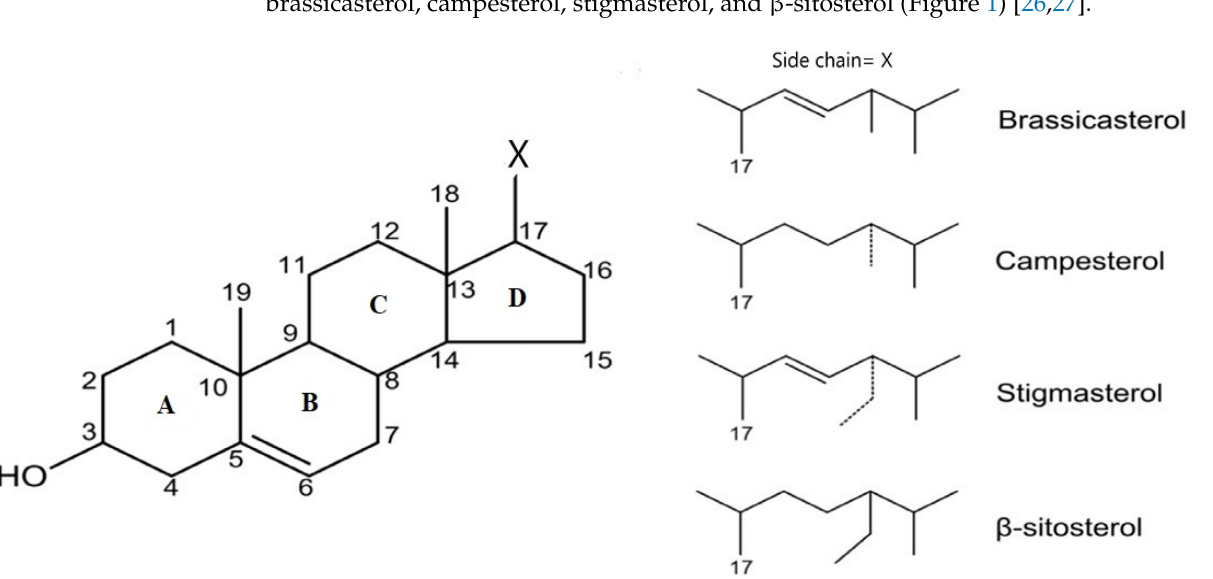
Figure 1. Main PSs chemical structure according to C-17 side chain.